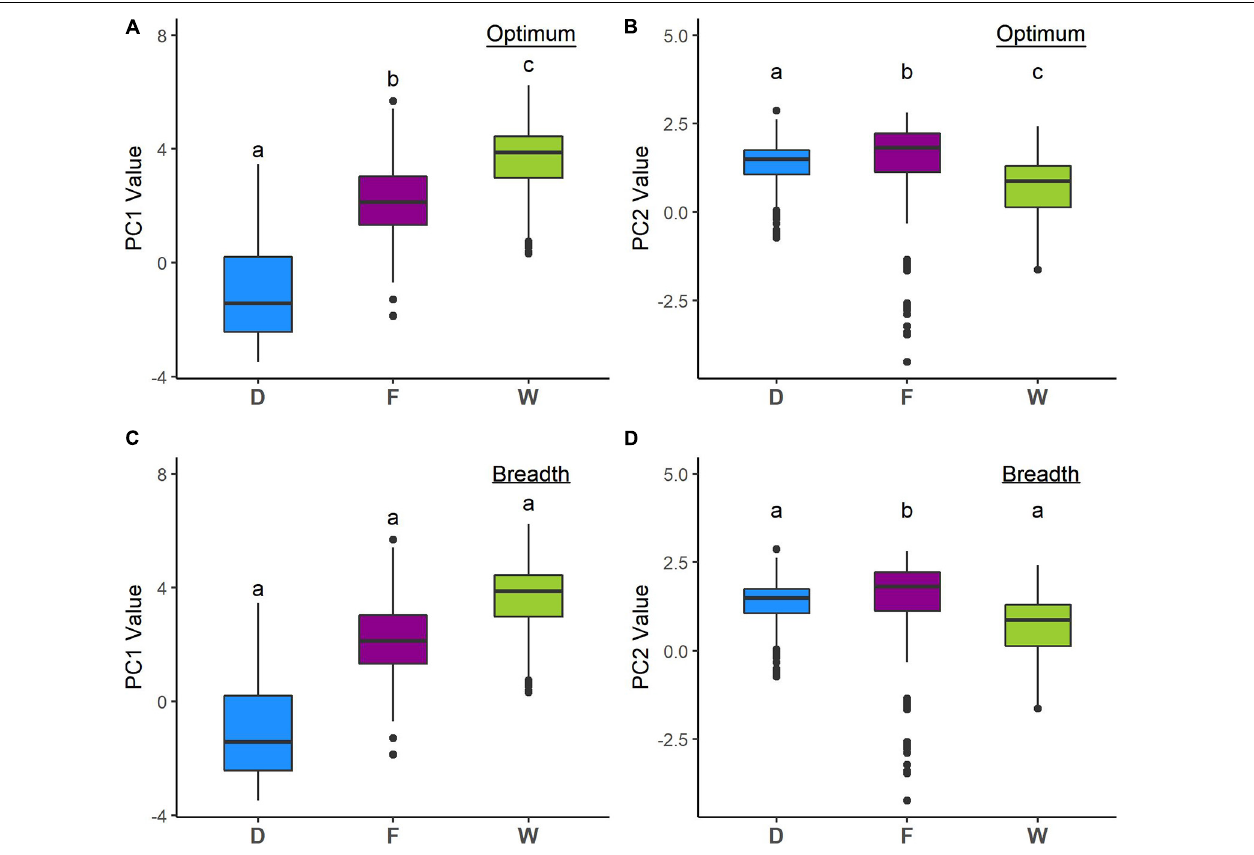
FIGURE 4 | Niche optimum and breadth of the two first principal components (PCA-env). Letters depict statistically significant differences according to bootstrap tests (see Table 4 ). Optimum corresponds to the median and breadth to the length of the 95% inter-percentile interval of the PCA values along the first two PC axes.